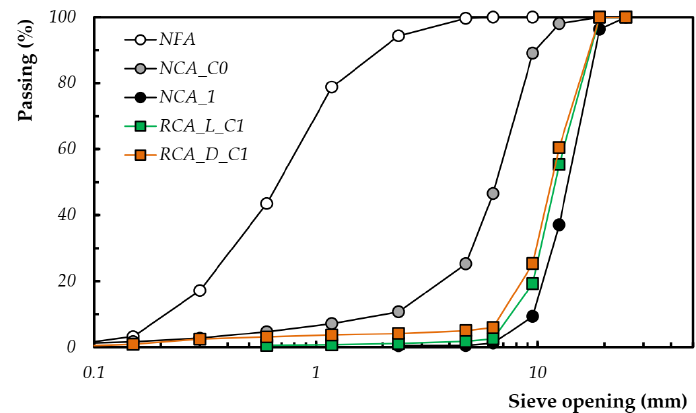
Figure 1. Grain size distribution of natural and recycled aggregates.